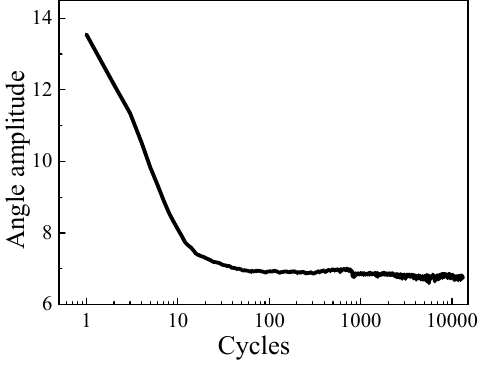
Figure 6. Angular amplitude vs. cycles.